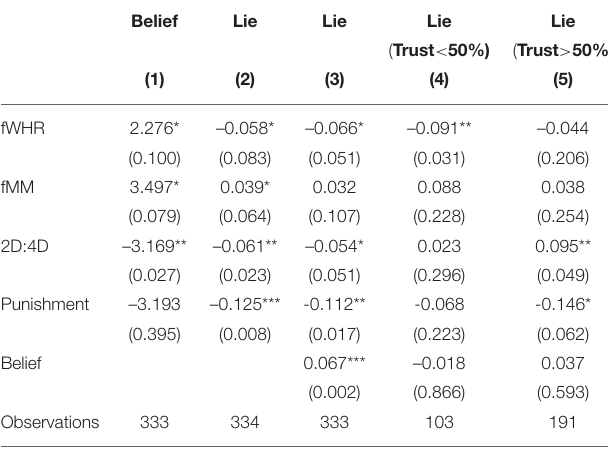
TABLE 5 | Random-effects